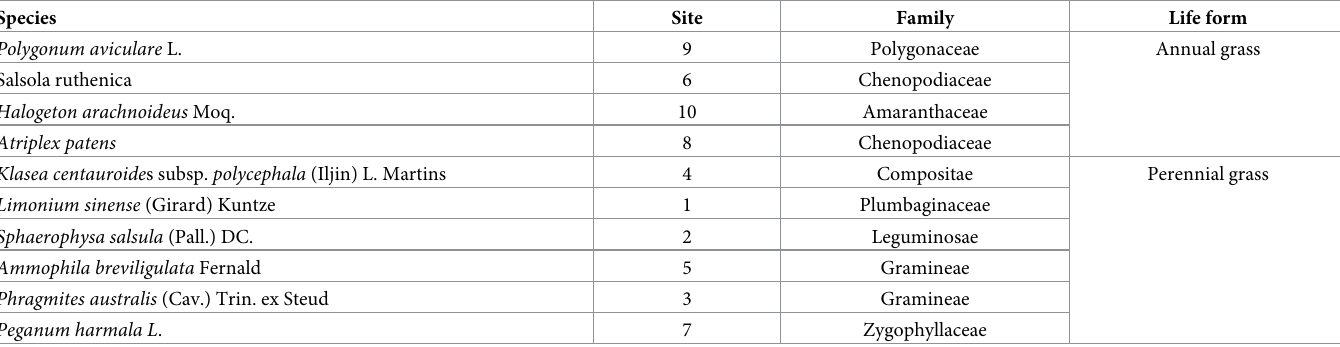
Table 1. Composition of native plant species around the tailing compounds.